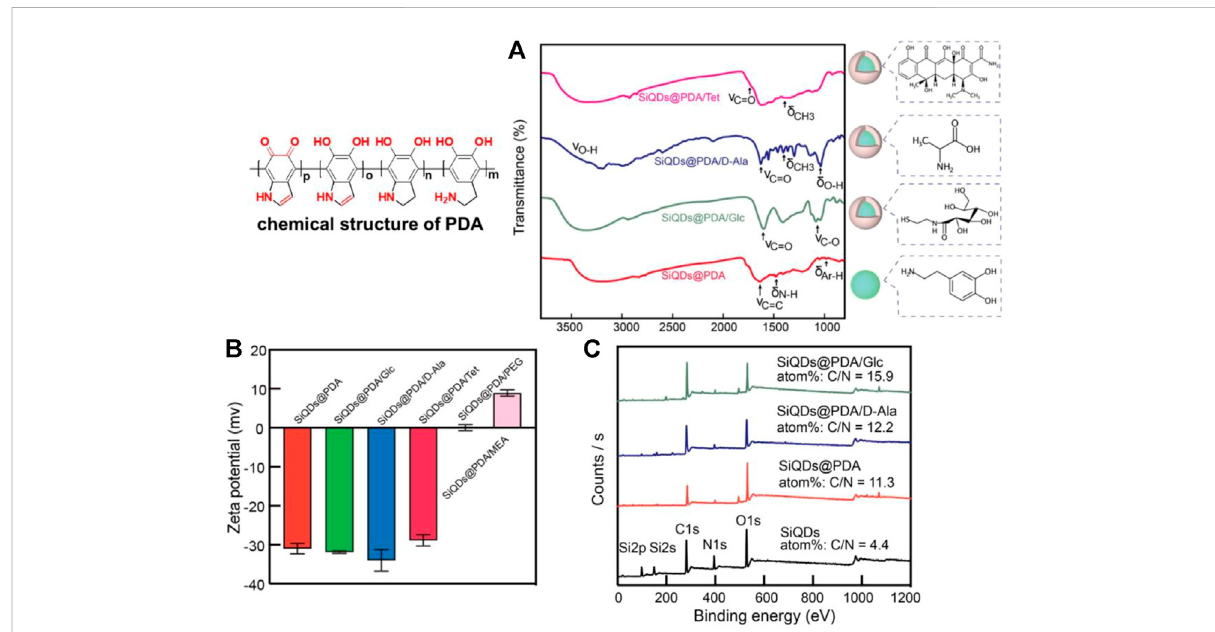
FIGURE 2 Characterization of functionalized SiQDs@PDA by various model molecules. (A) FTIR spectra of SiQDs@PDA after functionalization; (B) Zeta potential values of various model molecules – modi fi ed SiQDs@PDA in ultrapure aqueous solution; and (C) XPS results of D-Ala- and Glc- functionalized